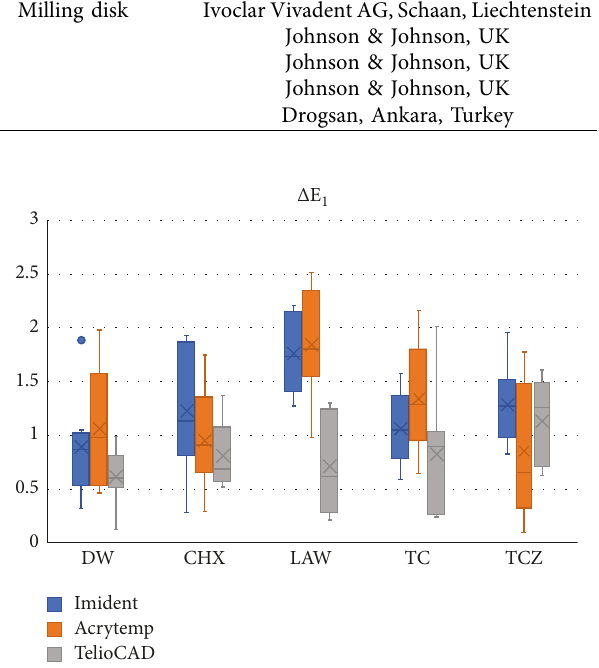
Figure 1: Δ E 1 values after